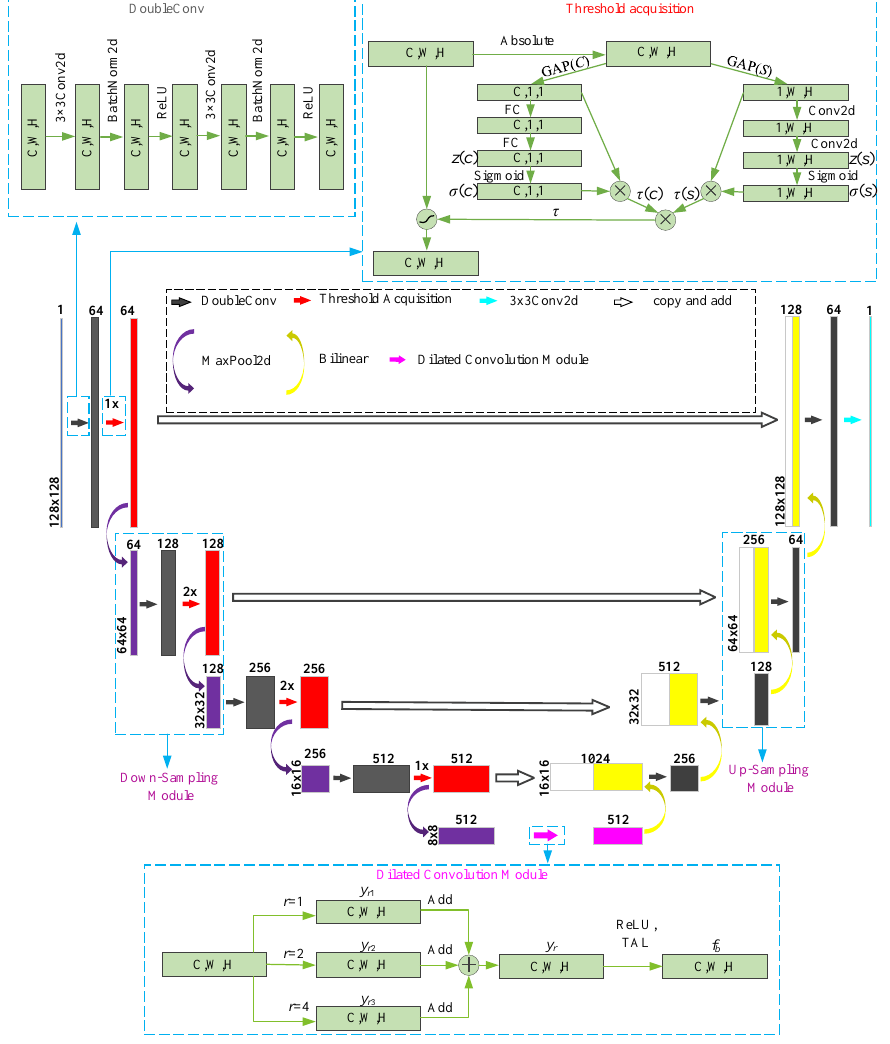
Figure 3. Structure of the proposed